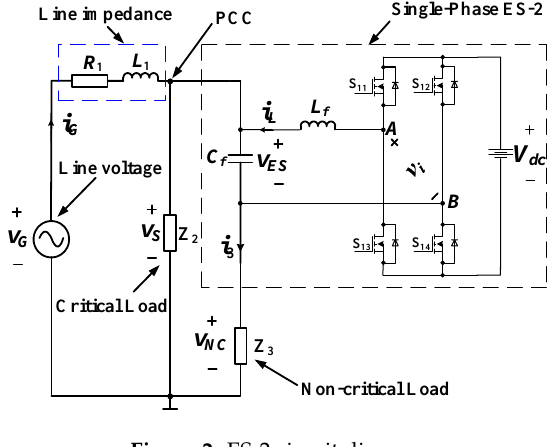
Figure 2. ES-2 circuit diagram.